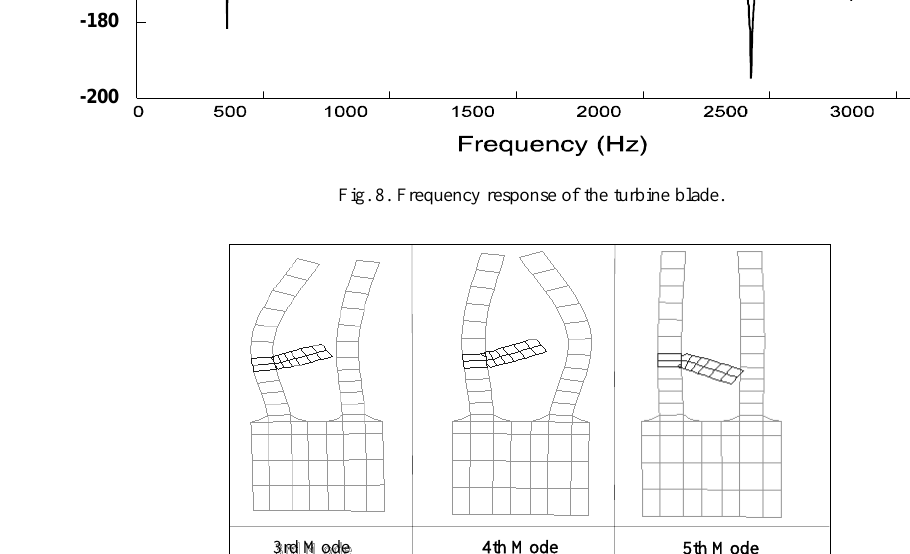
Fig. 9. 3rd, 4th and 5th mode